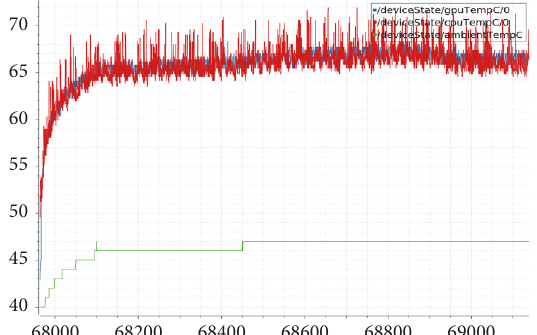
Figure 30: T1D6 temperatures.